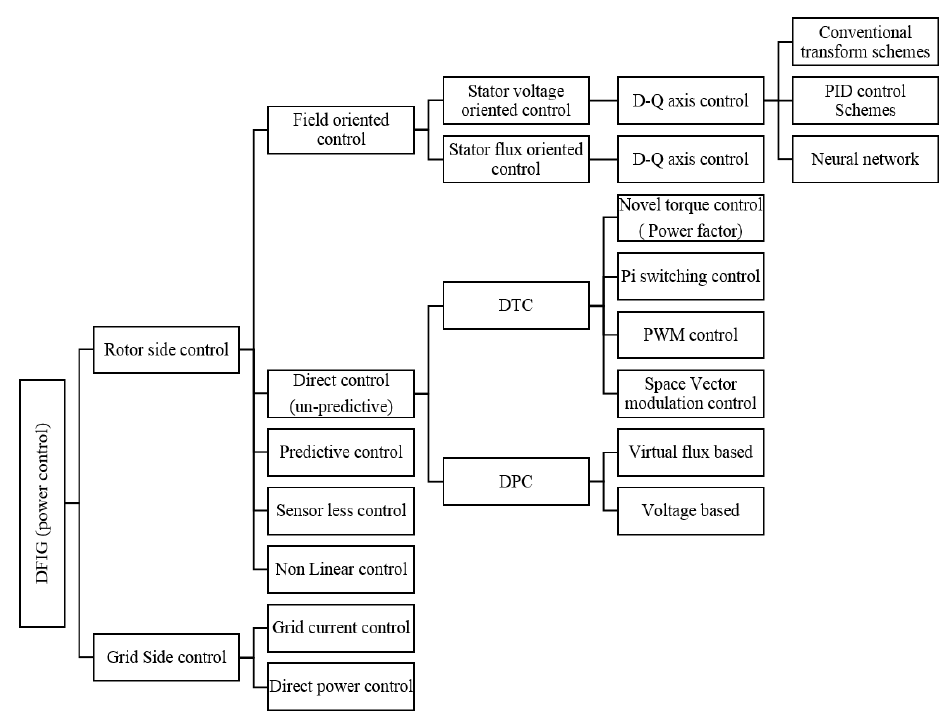
Figure 1. Power control schemes discussed in literature review.